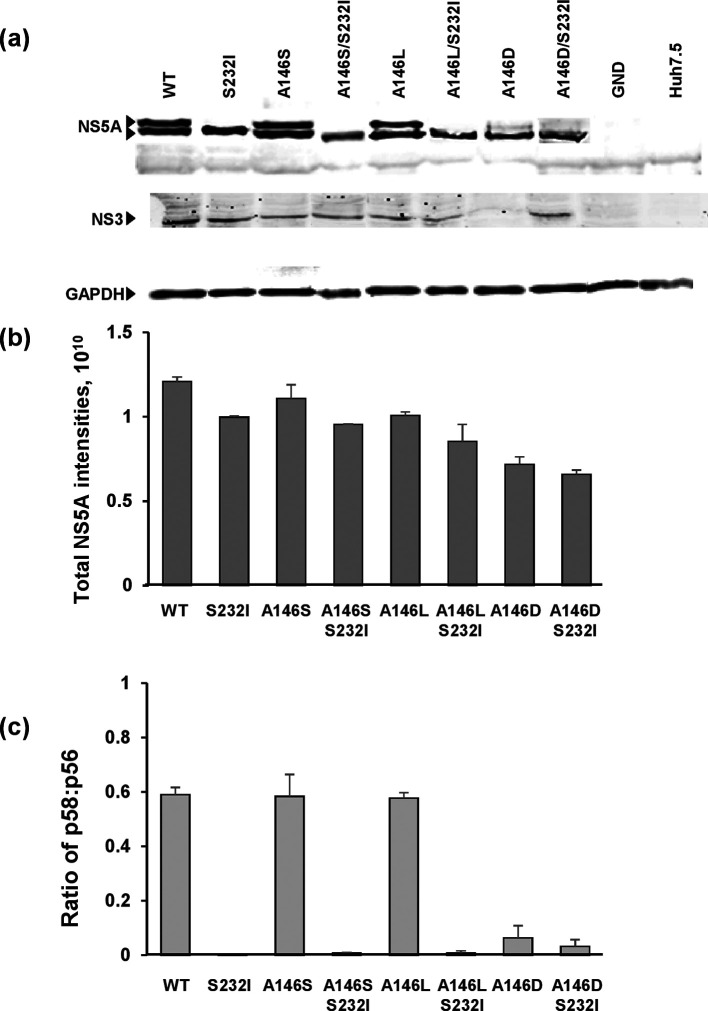
Effect of A146 mutation on NS5A expression and phosphorylation. Huh7.5 cells were electroporated with in vitro transcripts of the indicated SGR and incubated for 48 h p.e. (a) Cells were lysed and analysed by SDS-PAGE/Western blot with a sheep polyclonal antiserum to NS5A [34] or mouse monoclonal antiserum to NS3. (b, c) Total NS5A levels and the ratio of hyper- to basal-phosphorylation were quantified from fluorescent Western blots. Error bars show sem; data from three independent experiments are shown.